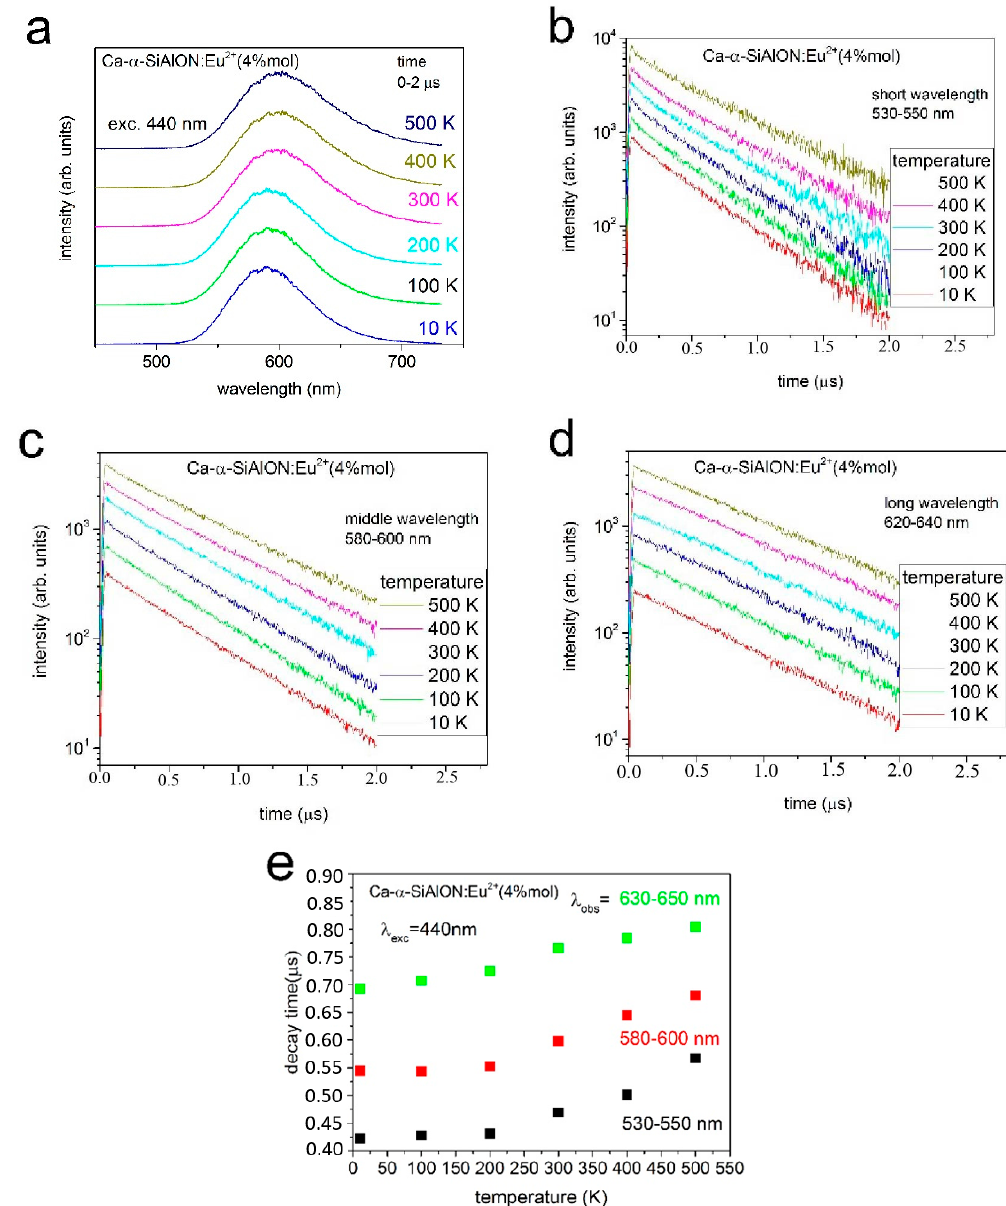
Figure 8. ( a ) Time resolved luminescence spectra of Ca 0.8 Si 9.6 Al 2.4 O 0.8 N 15.2 :Eu 2+ (4 mol%) observed in the time range 0–2 µs, excited with 440 nm at various temperature. ( b – d ) Luminescence decay curves of Ca 0.8 Si 9.6 Al 2.4 O 0.8 N 15.2 :Eu 2+ (4 mol%) excited with 440 nm at different temperatures. Luminescence decays are monitored at three region of wavelength ( b ) 530–550 nm ( c ) 580–600 nm ( d ) 630–650 nm (marked with rectangles) ( e ) Decay times calculated by single exponential fit of decay profiles for the selected region of luminescence wavelength.